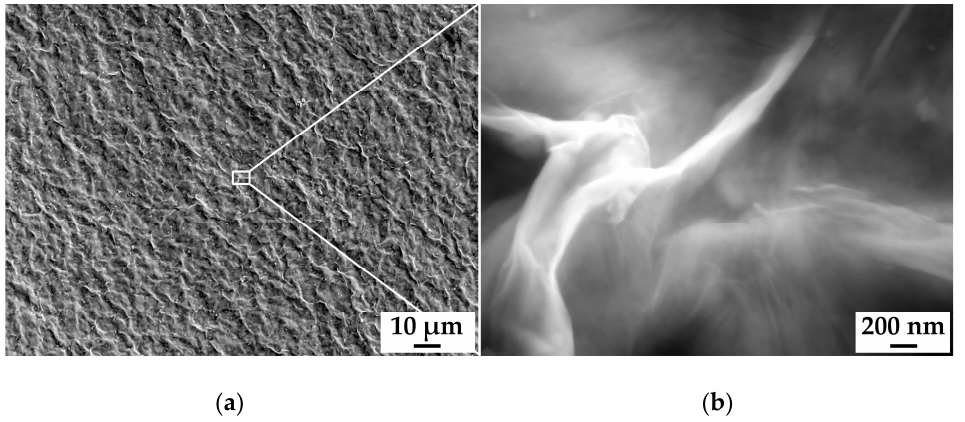
Figure 4. The characterization of Ti 0.2 V 1.8 C MXene layer placed from ink over the glass substrate by SEM under various magnifications: ( a ) ×2000, ( b )